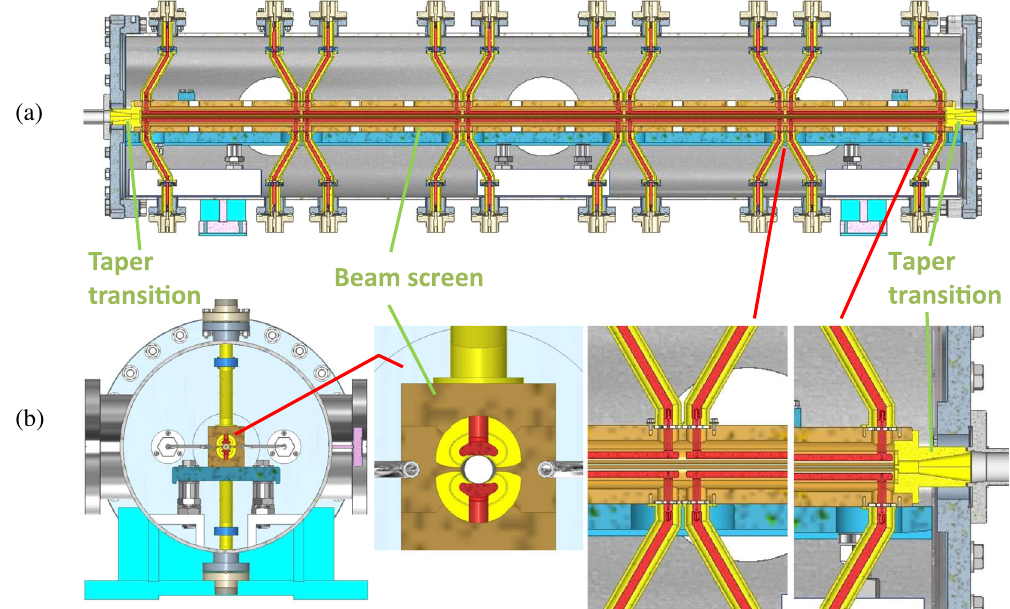
FIG. 1. CAD drawing of the five-cell stripline kicker: (a) longitudinal cross section along the beam axis, (b) transverse cross section in the middle of the stripline kicker and zoomed view of each end of the first set of